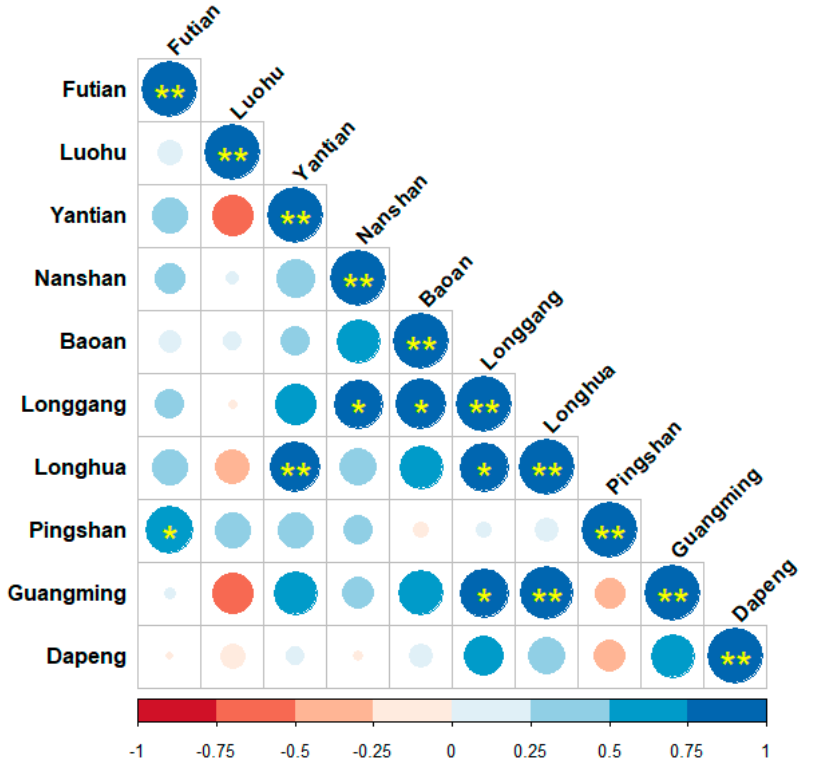
Figure 4. The correlations between FEW efficiencies among districts within Shenzhen City during 2012–2020 (The size of circle in different color indicates Pearson correlation coefficient with “*” indicating p < 0.05 and “**” indicating p < 0.01).